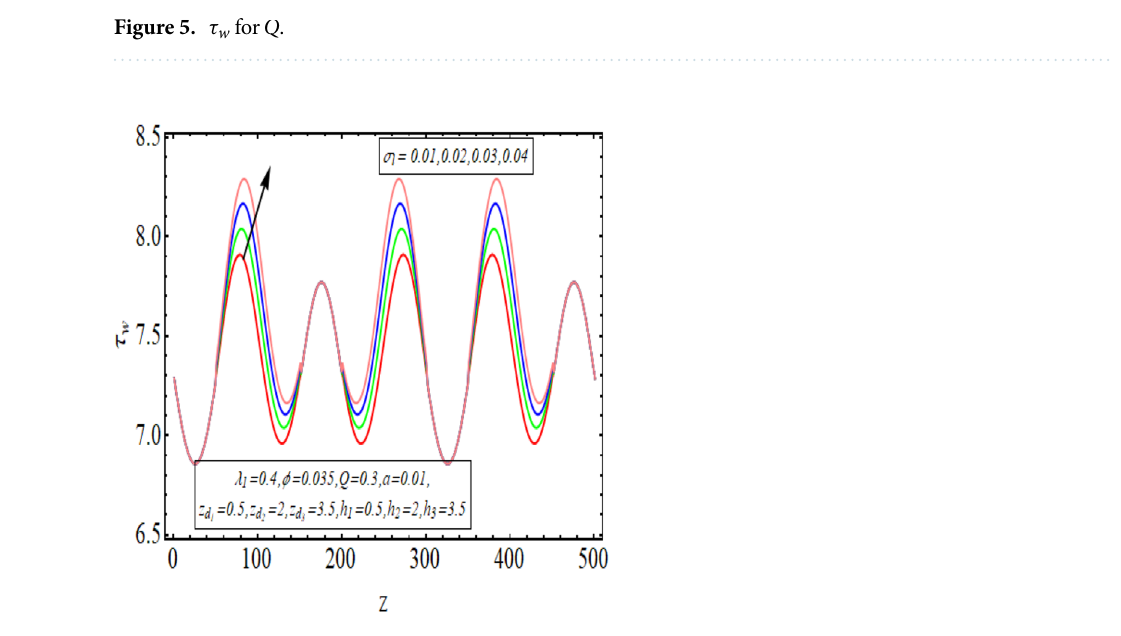
Figure 6. τ w for σ l